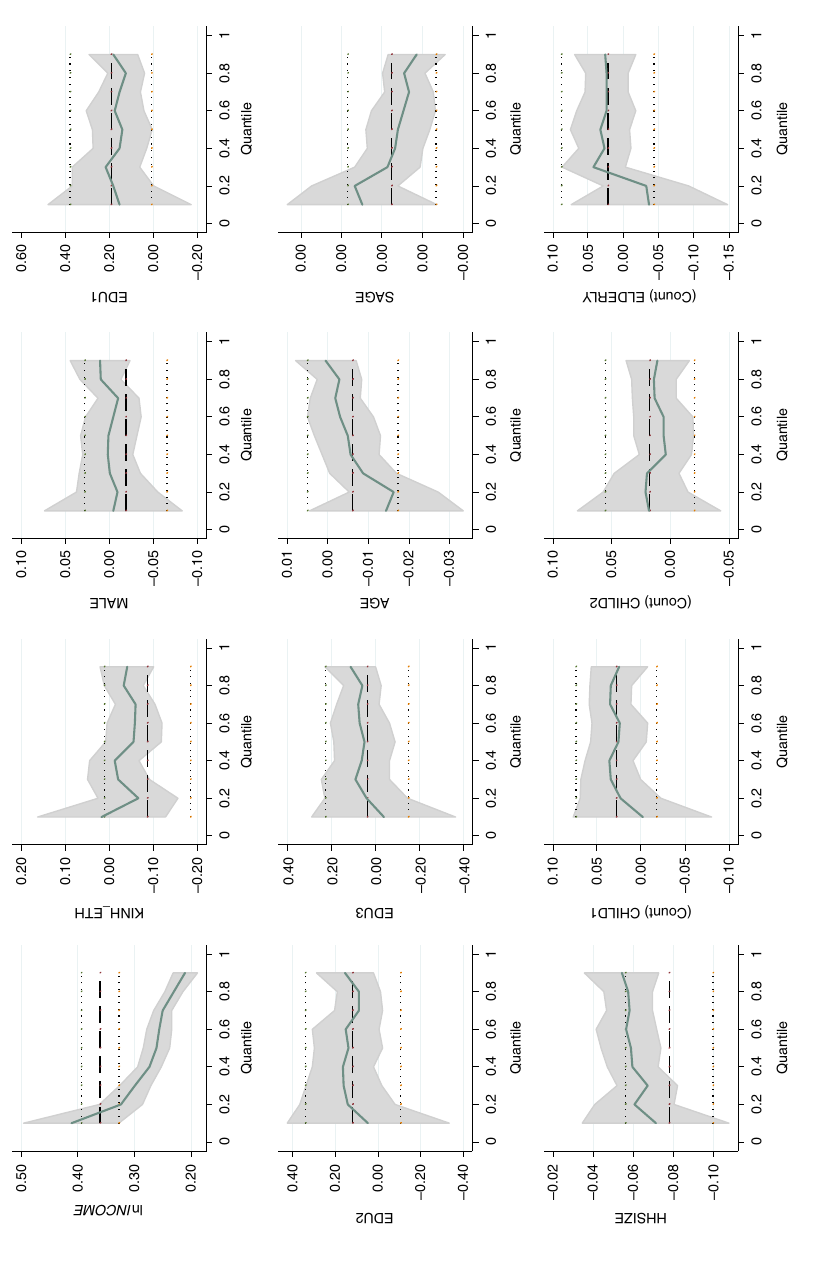
Figure 4. Ordinary least squares regression and quantile regression estimates for Vietnamese household saving rate in urban